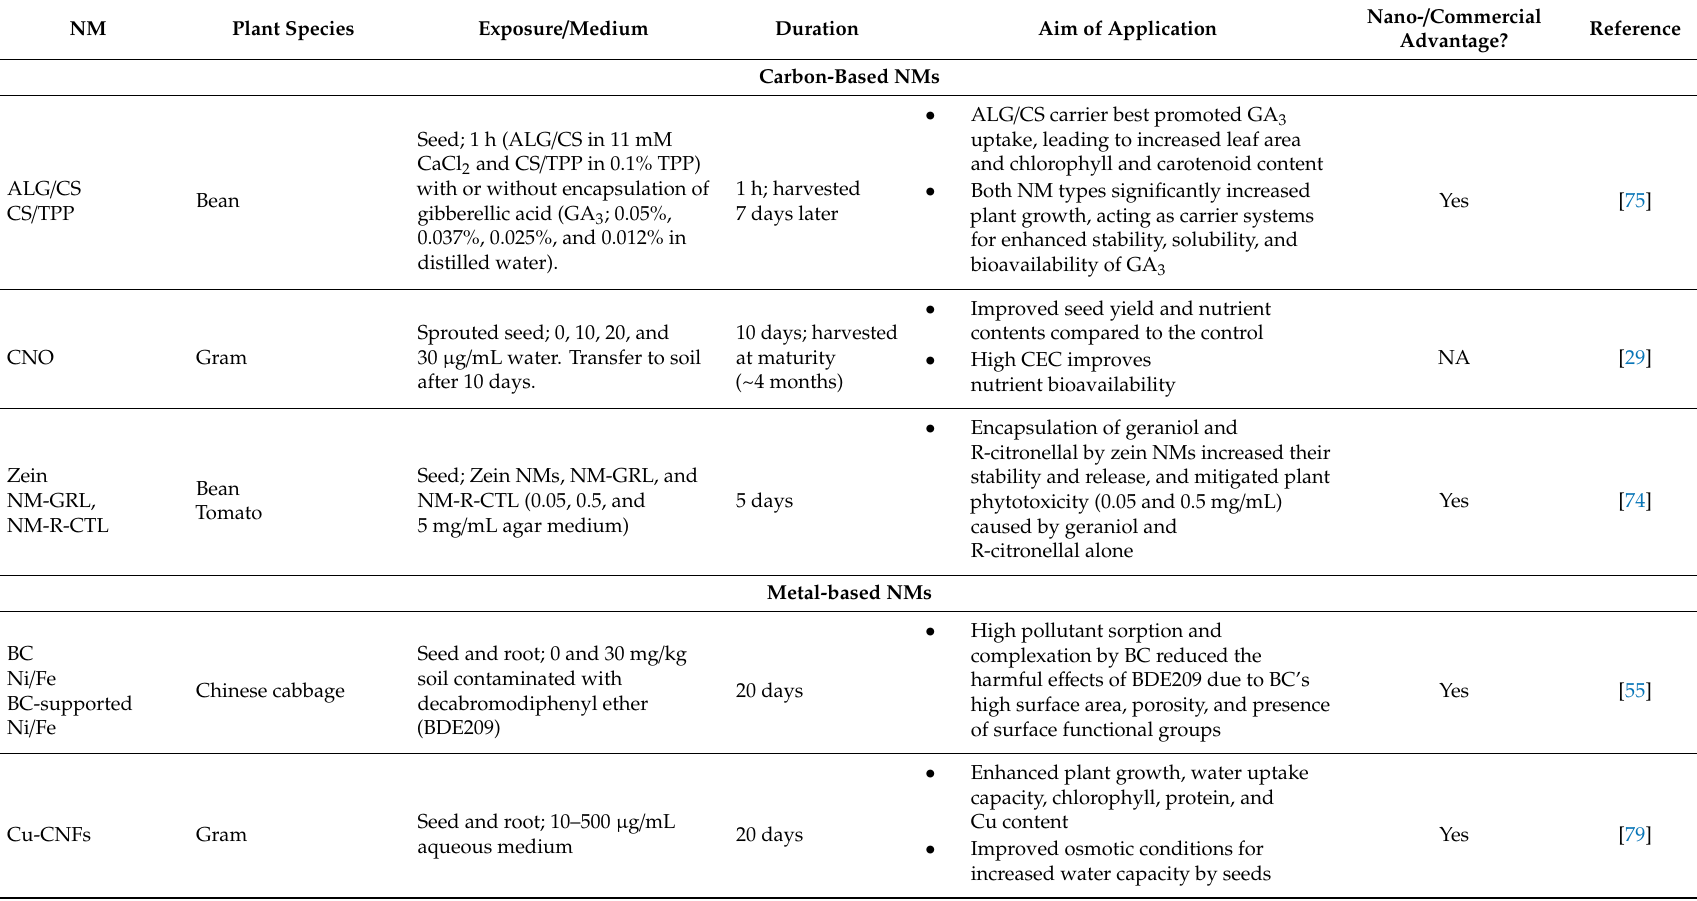
Table 4. ENMs for agricultural applications described in recent literature from 2017 and